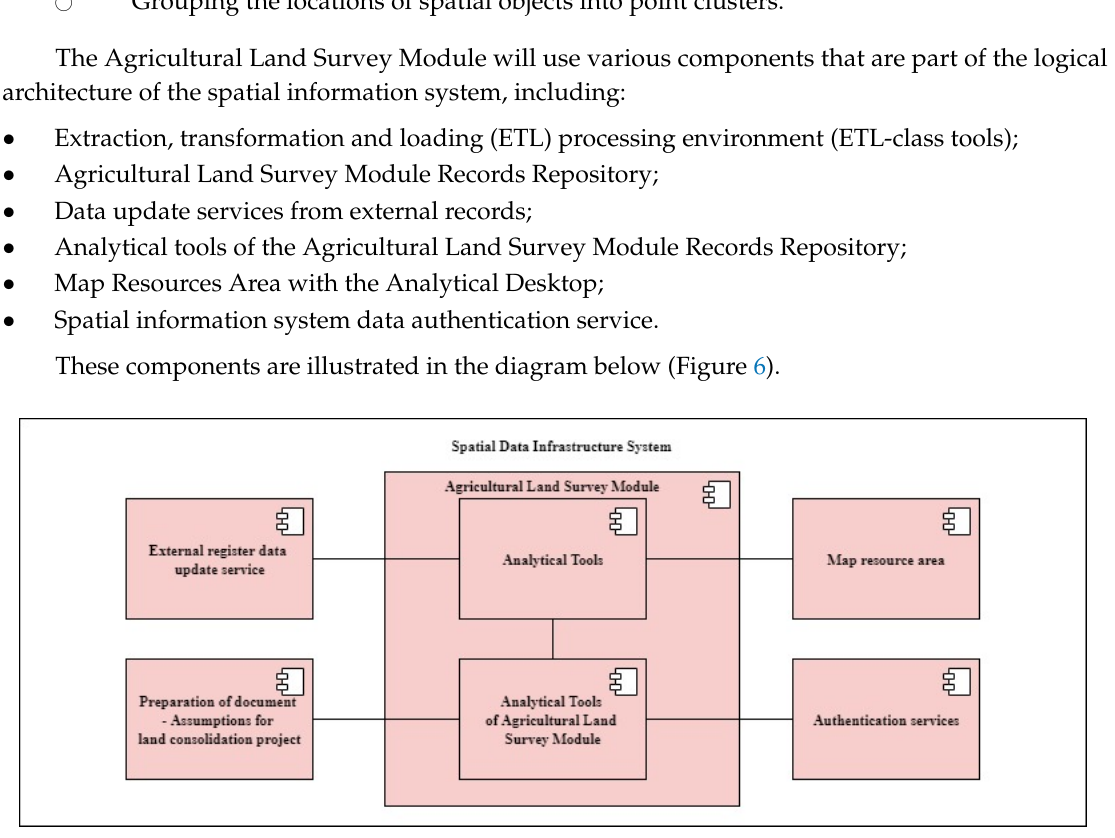
Figure 6. Logical architecture of the Agricultural Land Survey Module. Source: own study.